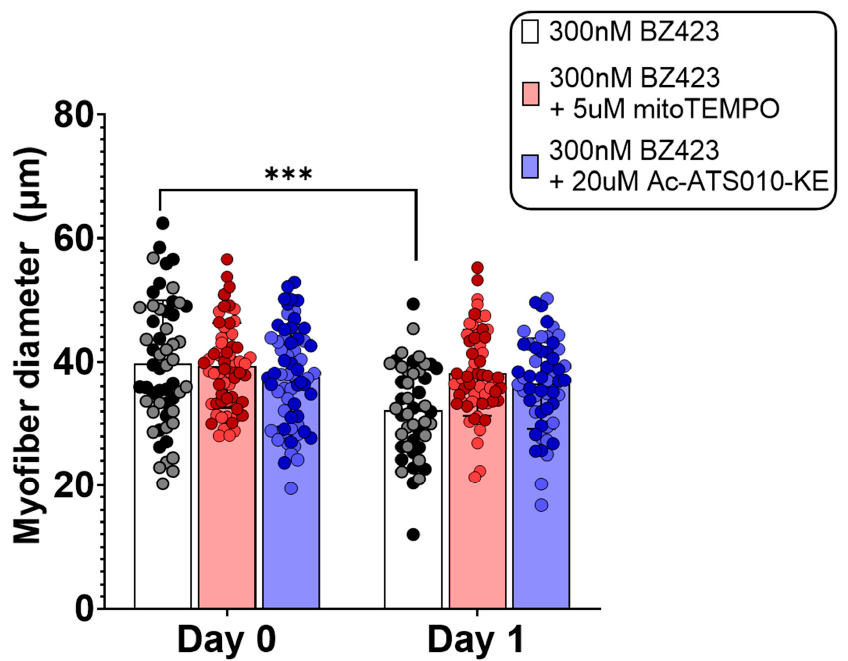
Figure 5. To determine if inhibition of mROS or caspase-3 prevents MPT-induced muscle fiber atrophy, isolated mouse FDB muscle fibers were treated with 300 nM Bz423 (MPT-inducer) or 300 nM Bz423 and either 5 µ M mitoTEMPO (mROS-inhibitor) or 20 µ M Ac-ATS010-KE (caspase-3-inhibitor). Both inhibition of mROS and caspase-3 prevented MPT-induced reduction in myofiber diameter. Biological replicates ( n = 2) are identified by data points of different colors within a given treatment, while technical replicates share the same color data point. *** p < 0.001 versus Day 0.